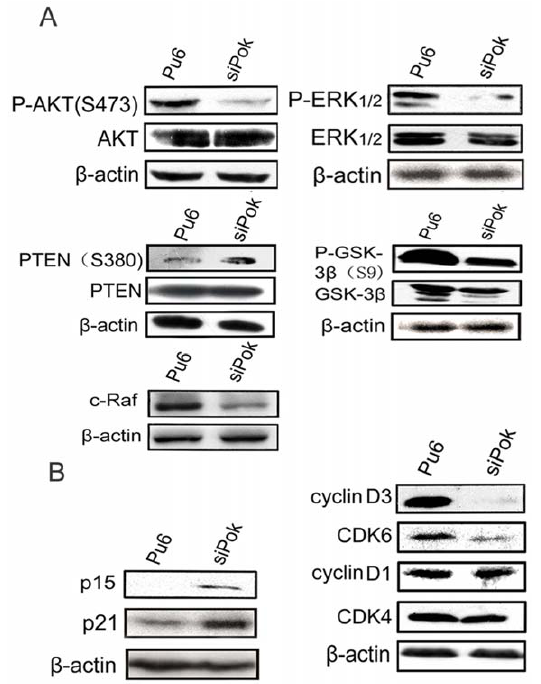
Figure 4. The effect of Pokemon on Akt and ERK signals as well as critical members of the cell cycle progression pathway. ( A ). Western blot analysis for the phosphorylation levels of Akt, Erk, PTEN, GSK-3 b and c-Raf in HepG2-siPokemon and control cells. ( B ). Western blot analysis for cell cycle-related proteins in HepG2-siPokemon and control cells.